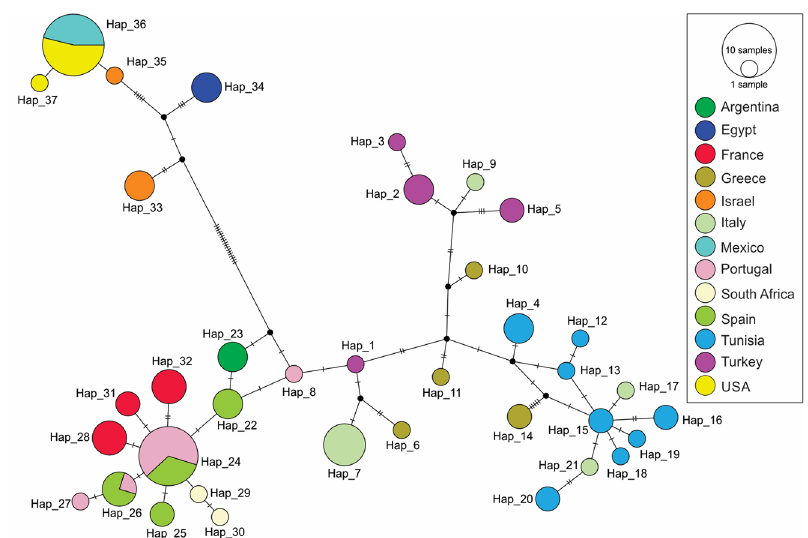
Fig 2. Neighbor-joining network of CO1 data. Haplotype network for the CO1 region for populations of Planococcus ficus collected in Europe, Africa, the Middle East, Argentina, California and Mexico. Each circle represents a different haplotype and the sizes of circles correspond to the number of individuals sharing this haplotype. Colors indicate sampling country. The crossbeam on the connecting lines between haplotypes represents a substitution. Black dots symbolize hypothetic haplotypes not sampled in the data set.